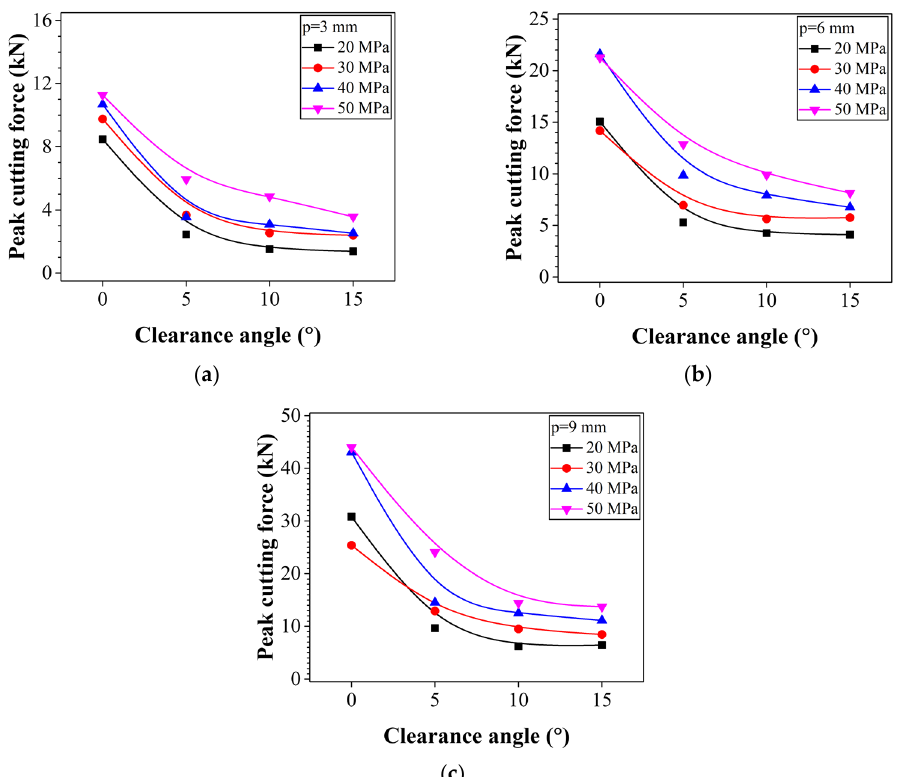
Figure 10. Relationship between the peak cutting force and clearance angle for cutting depths ( p ) of: ( a ) 3 mm, ( b ) 6 mm, and ( c ) 9 mm. Table 3. Mean and peak cutting forces for various clearance angles.